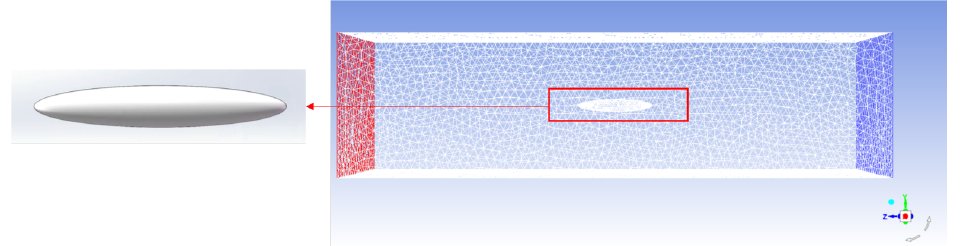
Figure 23. Standard ellipsoid model and its computational